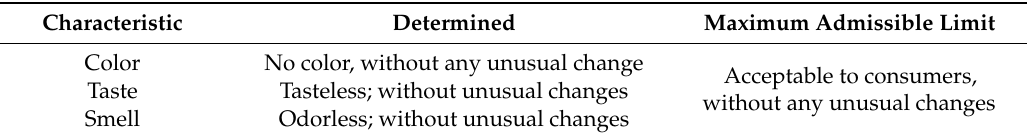
Table 7. Organoleptic analysis of “Roua Apusenilor” spring water, Sohodol village. Characteristic